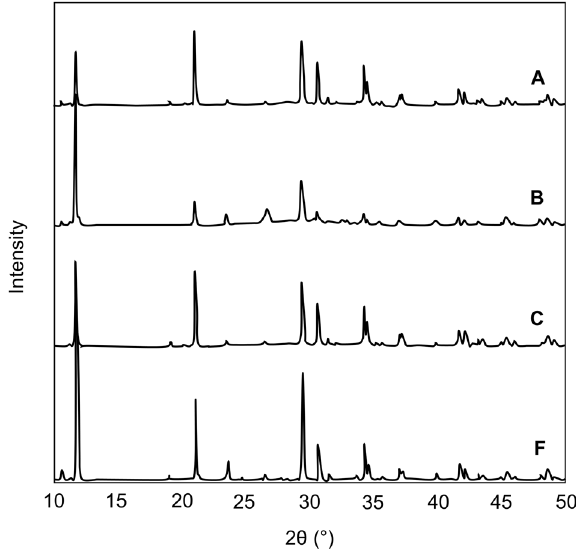
Fig. 7 Powder XRD patterns of samples prepared in experiments A growth of DCPD on DCPD seed material; B growth of DCPD on DCPD seed material in the presence of alanine; C growth of DCPD on DCPD seed material in the presence of glutamic acid and F: sponta- neously grown DCPD (labile growth zone)